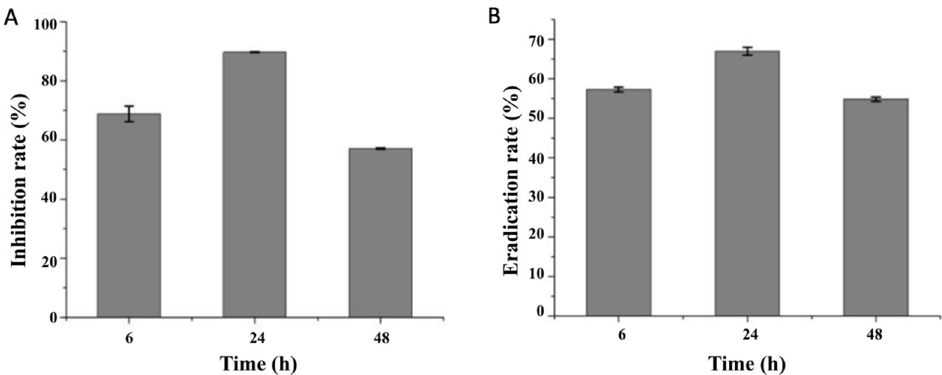
Figure 2. Effects of combined enzymes on V. parahaemolyticus biofilm: ( A ) formation rate; ( B ) eradication rate. Three technical replicates and three biological replicates were conducted.